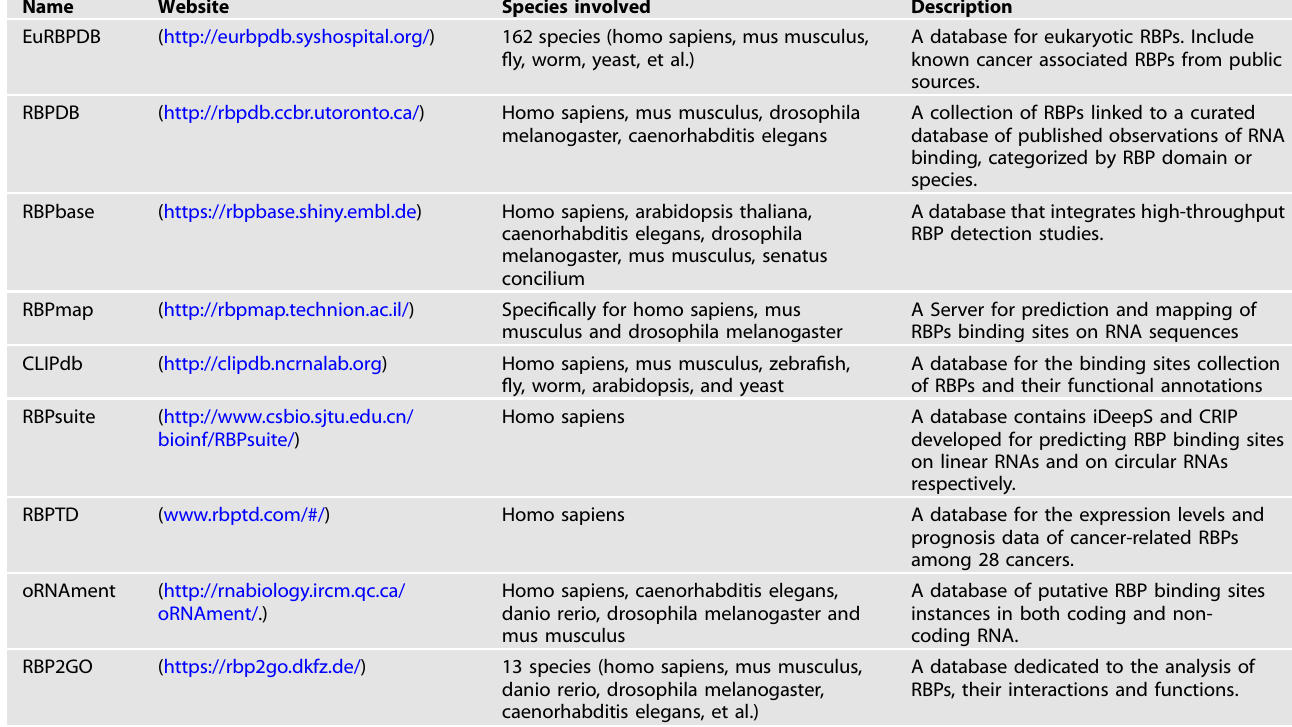
Table 1. Summary of online databases for eukaryotic